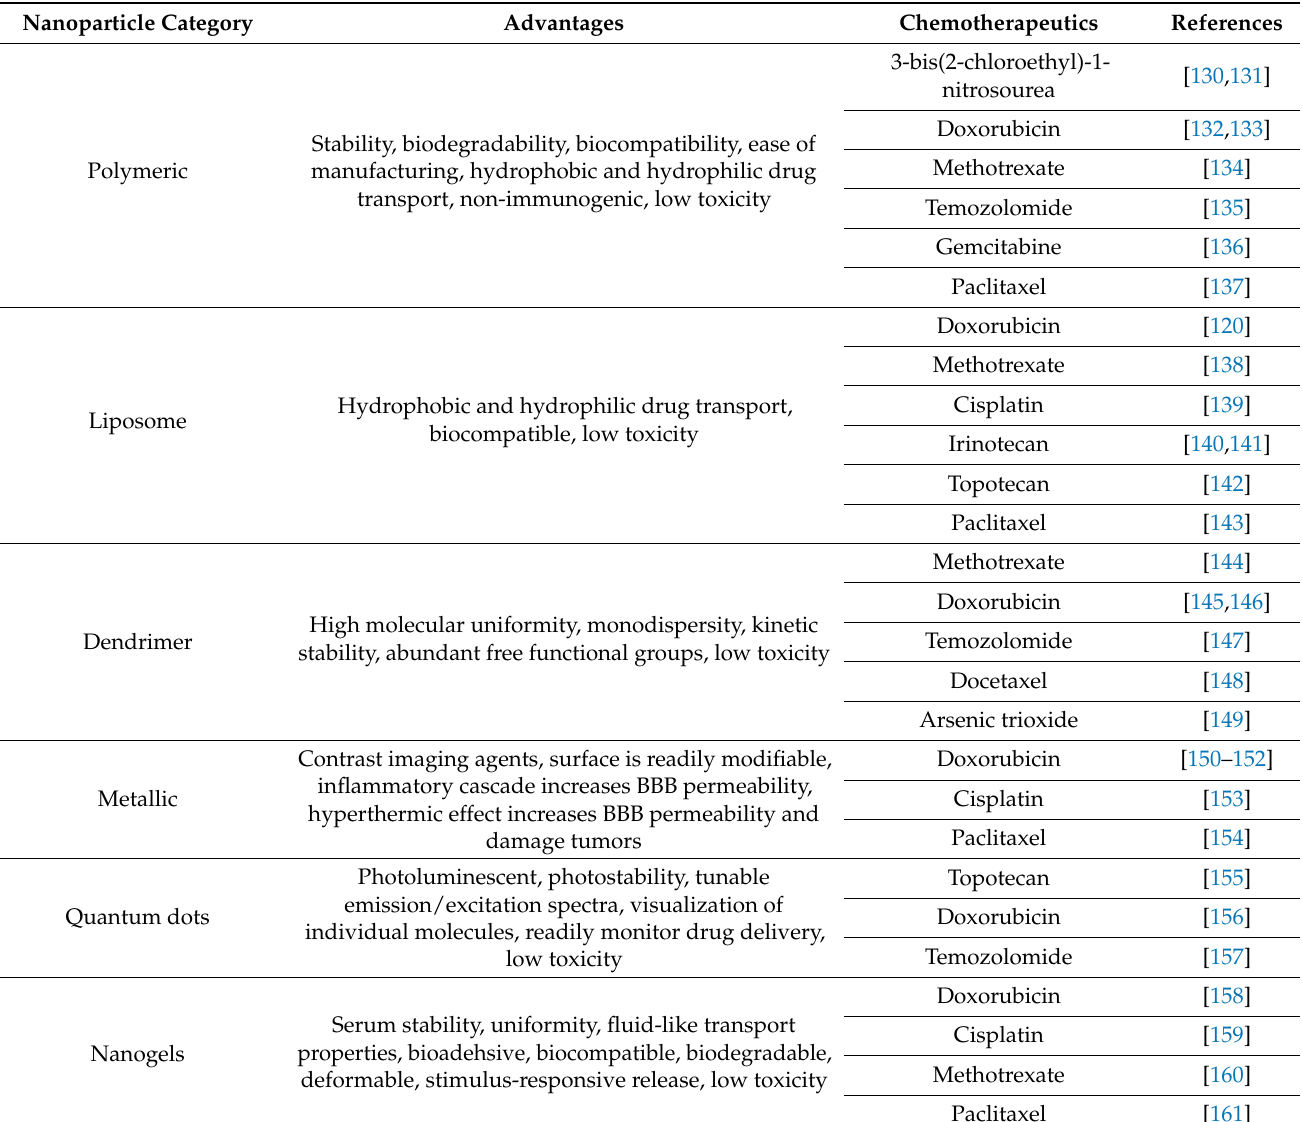
Table 1. Summary of NPs and select chemotherapeutic ligands investigated for treatment of brain tumors. In addition, NPs are capable of delivering RNA and DNA molecules as gene therapy and can play roles as imaging agents for